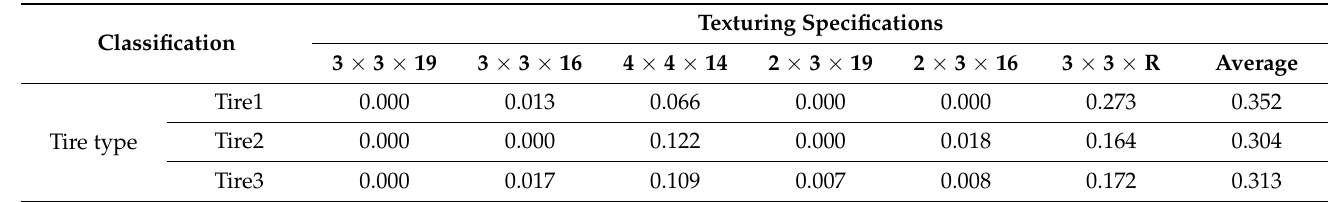
Table 4. Lateral vibration occurrence rate (panel rating